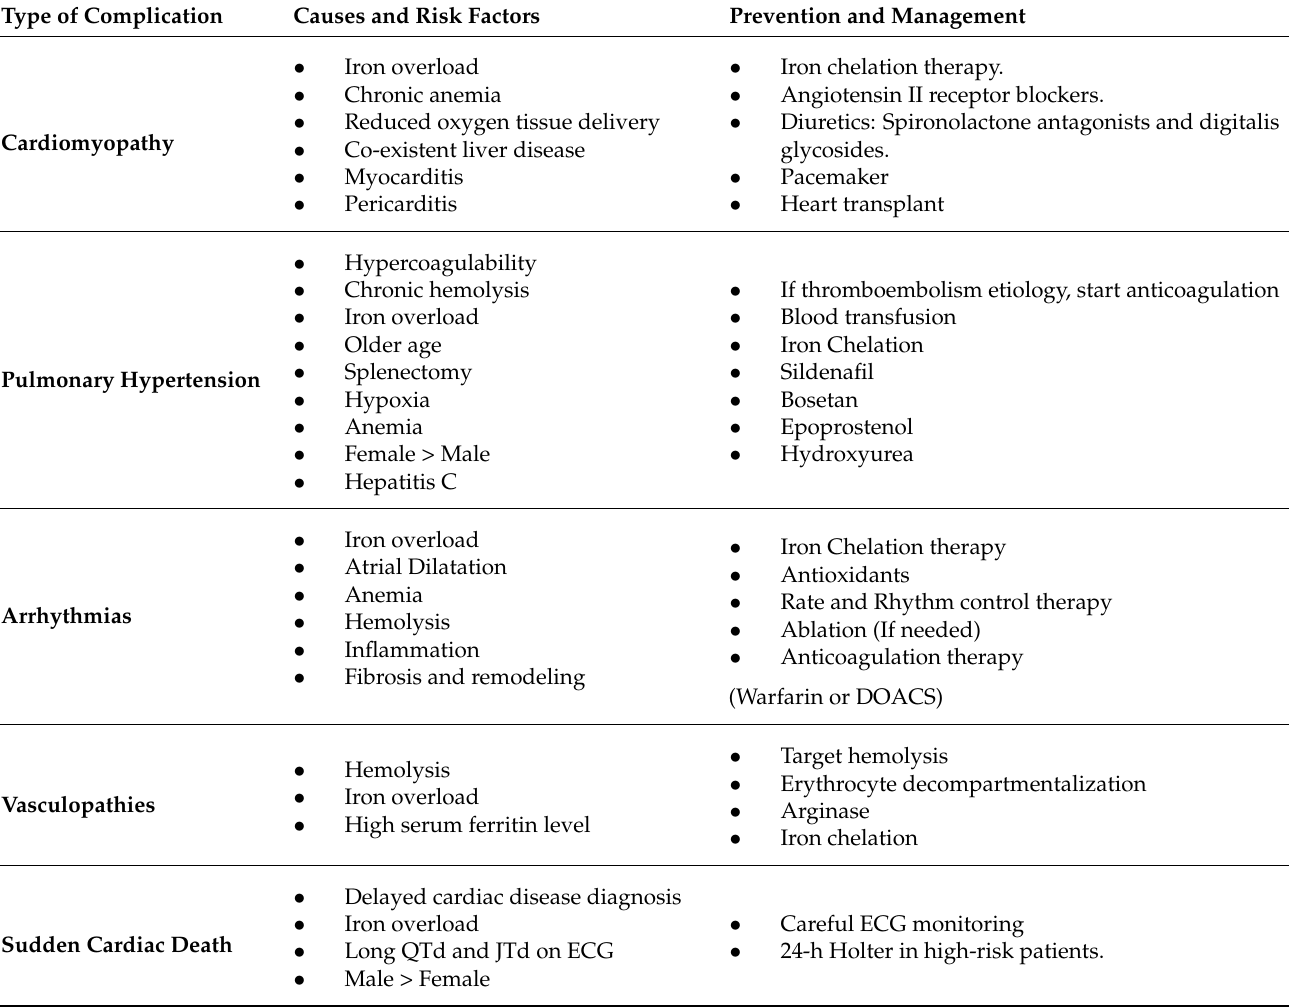
Table 2. Summary of different cardiovascular complications and management techniques in β -